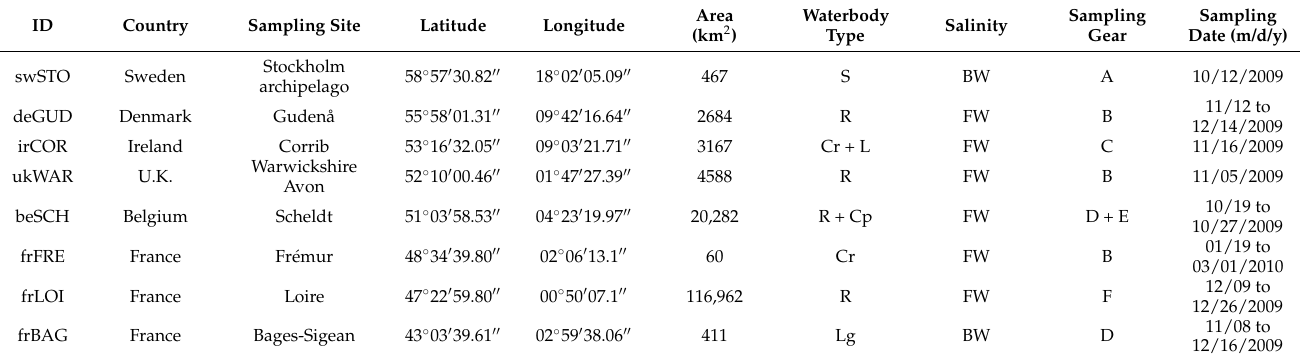
Table 1. Details of sampling